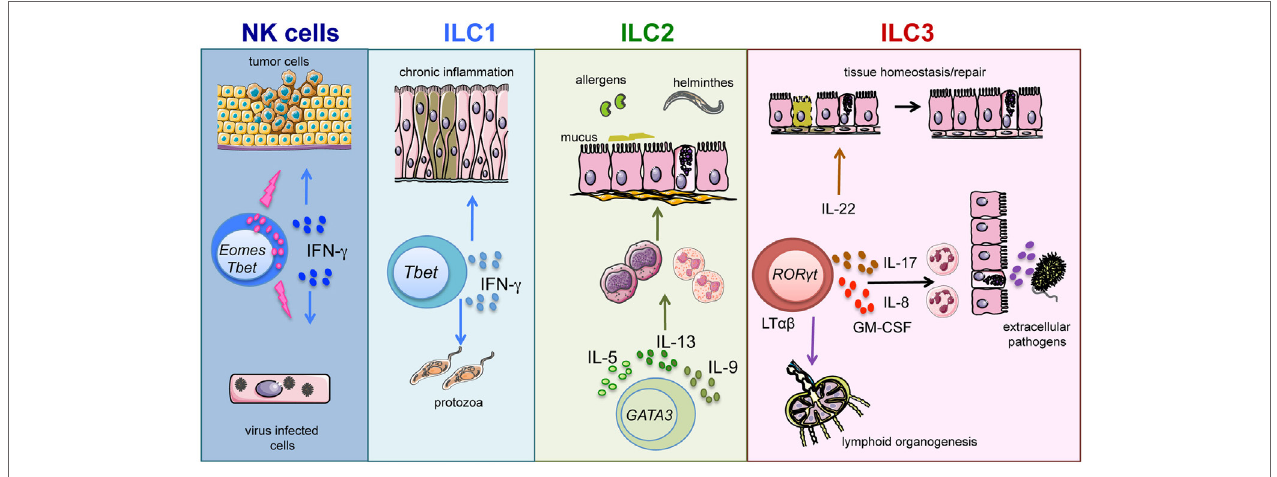
FiGURe 1 | iLC subsets and function . Graphic representation of the role played by ILC subsets in host defenses and tissue